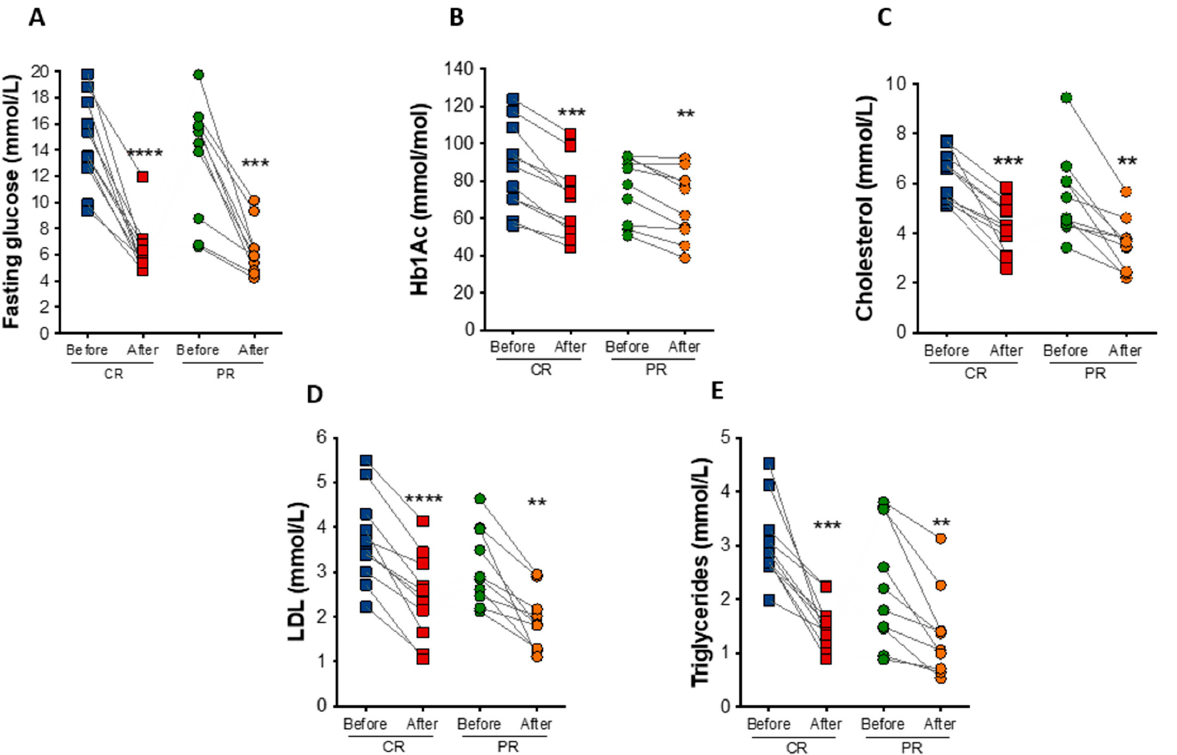
Figure 4. Biochemical changes after caloric restriction (CR) or protein restriction (PR). ( A ) Fasting glucose levels (**** p < 0.0001 and *** p = 0.0009). ( B ) Hemoglobin A1c (HbA1c) levels (*** p = 0.0001 and ** p = 0.0069). ( C ) Total cholesterol levels (*** p = 0.0002 and ** p = 0.0047). ( D ) low-density lipoprotein (LDL) cholesterol levels (**** p = <0.0001 and ** p = 0.0026). ( E ) Triglycerides levels (*** p = 0.0004 and ** p = 0.0097). Data are presented in dot-plot format. ANOVA mixed-design analysis of variance was performed.